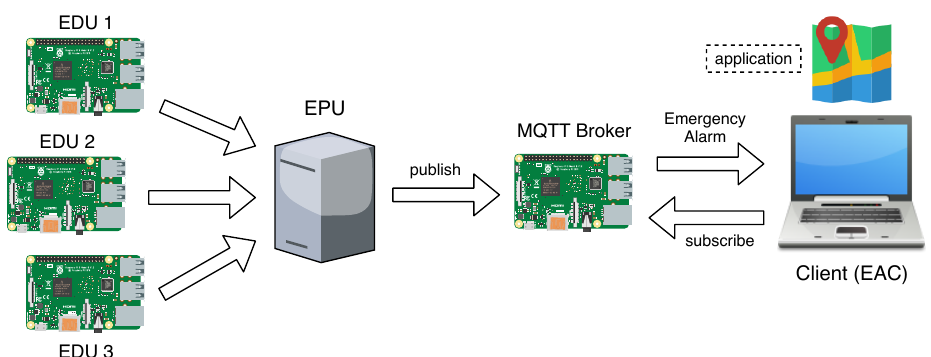
Figure 9. The defined experimental